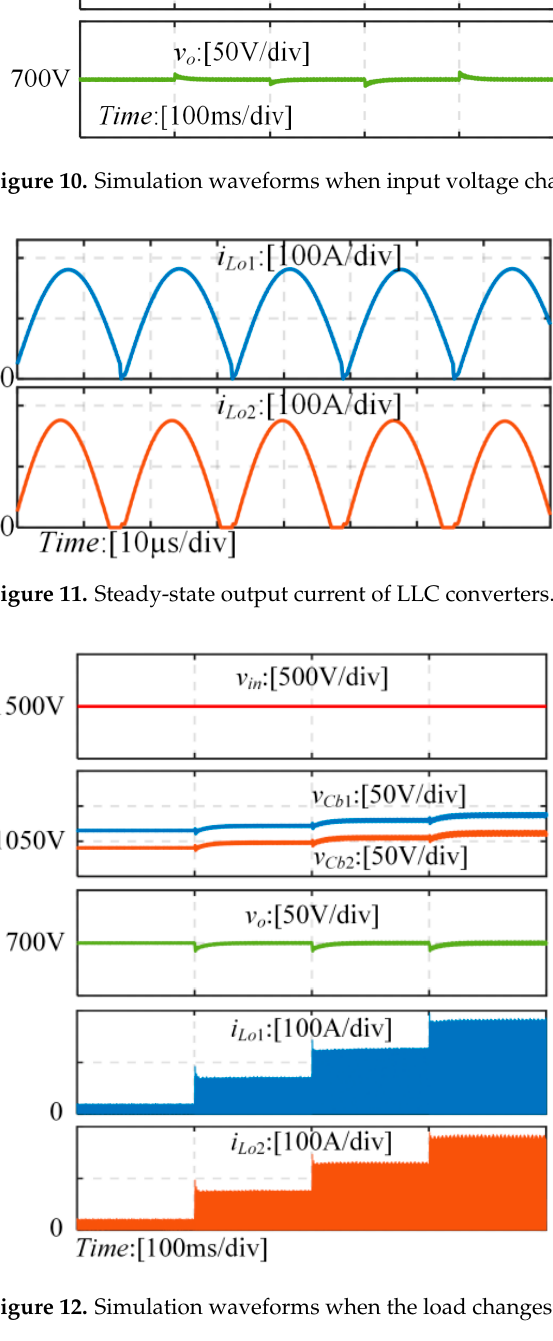
Figure 13. Experimental prototype and platform. Due to some error between the actual parameters and the design values, the circuit parameters of the two groups of submodules are not completely consistent. Table 3 shows the actual circuit parameters of the two groups of submodules. Thanks to the current man- ufacturing technology of magnetic components and capacitors, there is only a slight dif- ference in the parameters of resonant inductance and excitation inductance between the two submodules, and the other circuit parameters have a very good consistency. Figure 13 shows the experimental waveforms of the ISOP system under different loads, wherein i Ts 1 and i Ts2 are the output currents of the transformer secondary sides of two groups of submodules, respectively. It can be seen from the figure that under different loads, the output voltage of the ISOP system is stable at 700 V, and the intermediate bus voltage and output current of the two groups of submodules show very good consistency. Figure 14 gives the experimental waveforms of the ISOP system under different input voltages. It can be seen that under different input voltages, the output voltages of the ISOP system are all stable at 700 V, and the intermediate bus voltages of the two groups of submodules show very good consistency. Table 3. Real circuit parameters of the two submodules. C b (µF)